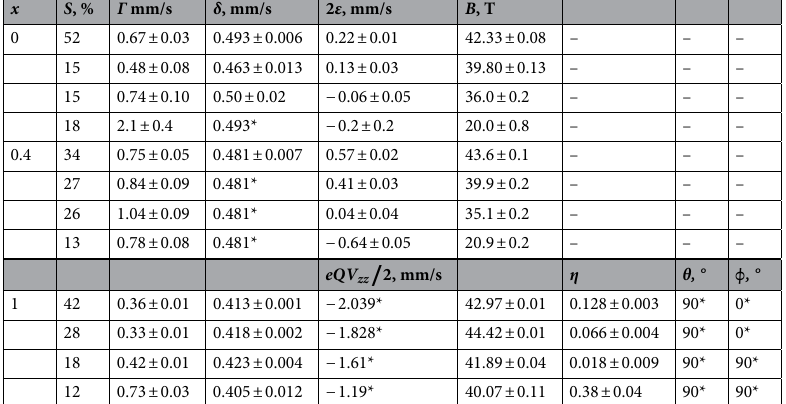
consider only first order corrections (Eq. (2)). The term of quadrupole interaction was fixed according to room temperature data, | eQV zz | / 2 ≈ � (Eq. (1), Tables 2 and 3). In case of hexagonal YMn 0.97 Fe 0.03 O 3 the angle θ = 90° (Table 3) corresponds to EFG z axis along crystal c axis and the magnetization in ab plane 39,42,58,59 . The angle φ between magnetization projection into EFG xy plane and x axis had small influence on fitting quality and was fixed to 0 or 90° trying to keep 0 < η < 1 (Table 3) . When asymmetry of EFG 37 which expressed by parameter η is small, according to Eq. (2) the spins of Fe lying at different angles in ab plane resulted only in small changes in position of lines of Mössbauer spectrum and can be ascribed to the same subspectrum with slightly larger width of lines. Negative sign of eQV zz / 2 for YMn 0.97 Fe 0.03 O 3 was in agreement with point charge calculations of EFG in case of hexagonal structure of rare earth manganites YMnO 3 and YbMnO 3 38,40 . Four subspectra (Table 3) which were fitted to Mössbauer spectrum of YMn 0.97 Fe 0.03 O 3 measured at 12 K correspond to doublets because of fixing eQV zz / 2 and area ratios of subspectra. Largest difference in hyperfine field B values of subspectra was ≈3 T indi- cating that the spectrum is broadened because of variation of both dipole magnetic and quadrupole interactions. At lowest 11–12 K temperature the lines of Mössbauer spectra of GdMn 0.97 Fe 0.03 O 3 and especially Y 0.4 Gd 0.6 Mn 0.97 Fe 0.03 O 3 (Fig. 8b,c) were broader than those of YMn 0.97 Fe 0.03 O 3 . Four sextets with different param- eters B and 2 ε were fitted to Mössbauer spectra (Table 3). Quadrupole shifts of subspectra were smaller than those of YMn 0.97 Fe 0.03 O 3 calculated according to Eq. (2) as shown in Fig. 9b, but hyperfine field B of sextets varied from 20 to ≈42 T. Such differences arise because of lower magnetic ordering temperature, crystal structure and spin ordering specifics. Hyperfine field distributions P( B ) were used for fitting to the Mössbauer spectra (Figs. 8 and 10) measured at higher then 11–12 K temperature up to transition to paramagnetic state. The shape of distributions is charac- terized by the features that are specific of different studied samples. Hyperfine distributions of YMn 0.97 Fe 0.03 O 3 exhibited one peak within 35–45 T hyperfine field range which intensity decreased as temperature increased (Figs. 9c and 10a). Two peaks within 30–45 and 10–20 T hyperfine field regions (Fig. 9c) were characteristic of